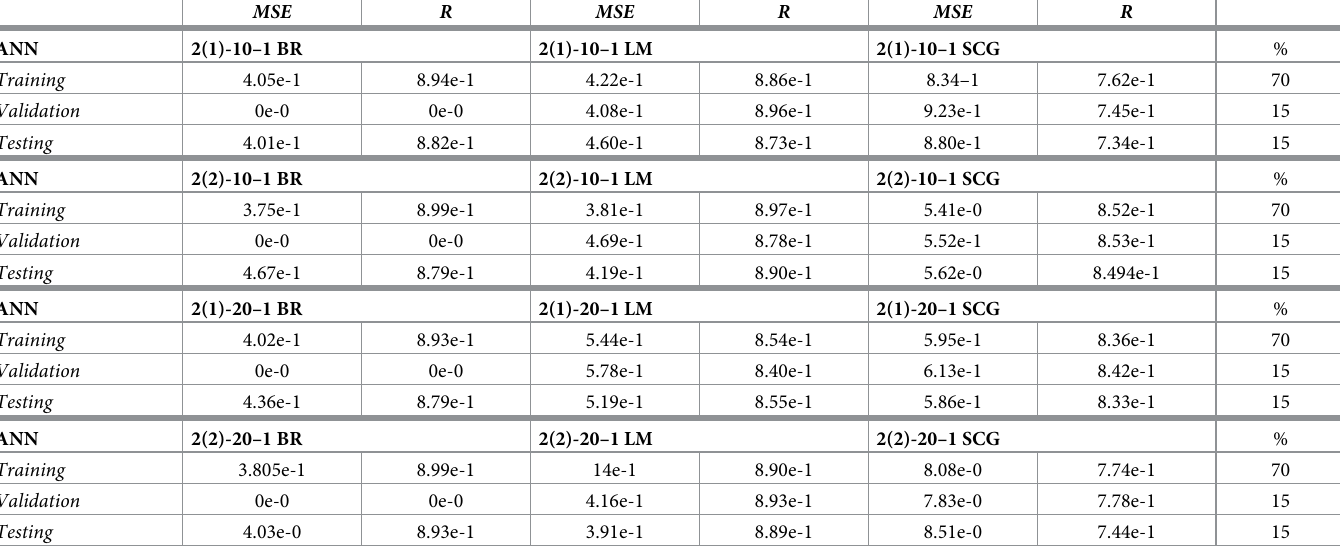
Table 5. BR—Bayesian Regularization training, LM -Levenberg-Marquardt training algorithm, SCG—Scaled Conjugate Gradient, the number in the brackets indi- cates the size of the time window delay for input and output, (2) two past values included, or (1) single past value included, evaluated for oak. MSE R MSE